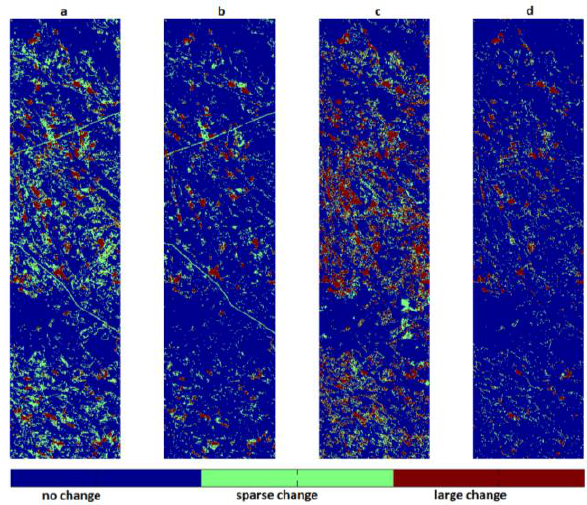
Figure 5. Classification of the surfaces: blue – ‘no change’, green – ‘sparse change’, dark red – ‘large change’. Surfaces from left: a) ALS-after-storm UMD, b) ALS – after-storm NGATE, c) pre-storm NGATE – after-storm UMD, d) pre- storm NGATE – after-storm NGATE